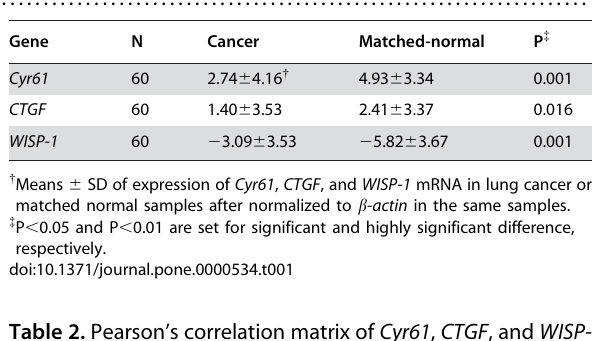
Table 2. Pearson’s correlation matrix of Cyr61 , CTGF , and WISP-